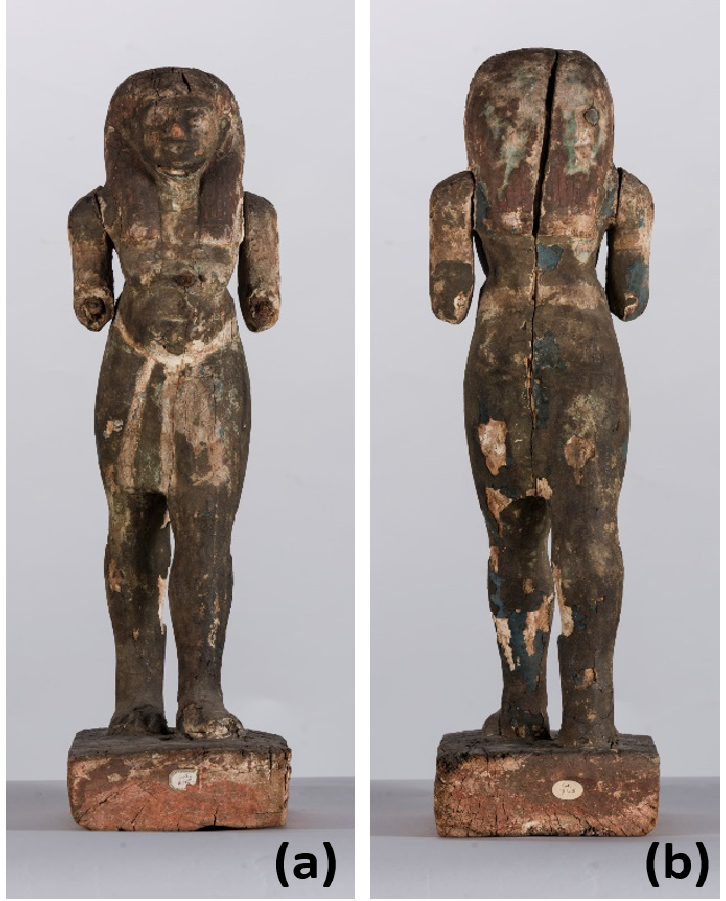
Figure 1. Inventory Number Cat. 745 before the cleaning treatment. Measurements (h × w × d) 62 cm × 16 cm × 25.5 cm. ( a ): front side, diffuse light. ( b ): back side, diffuse light.